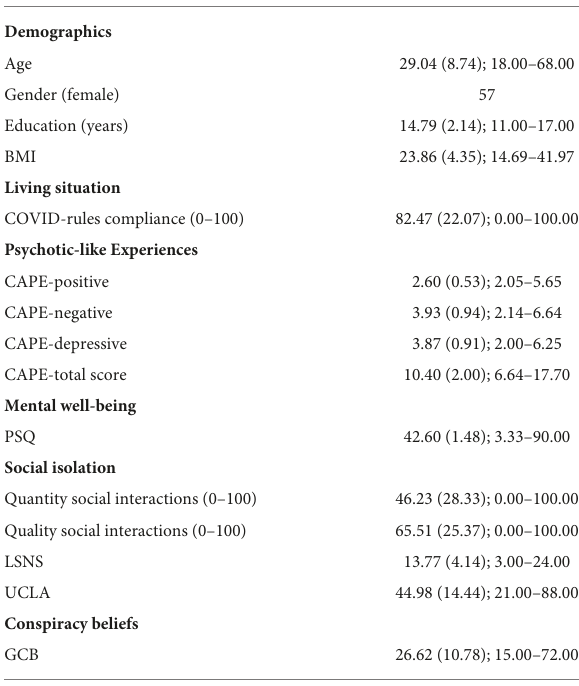
TABLE 1 Sociodemographic variables and questionnaires